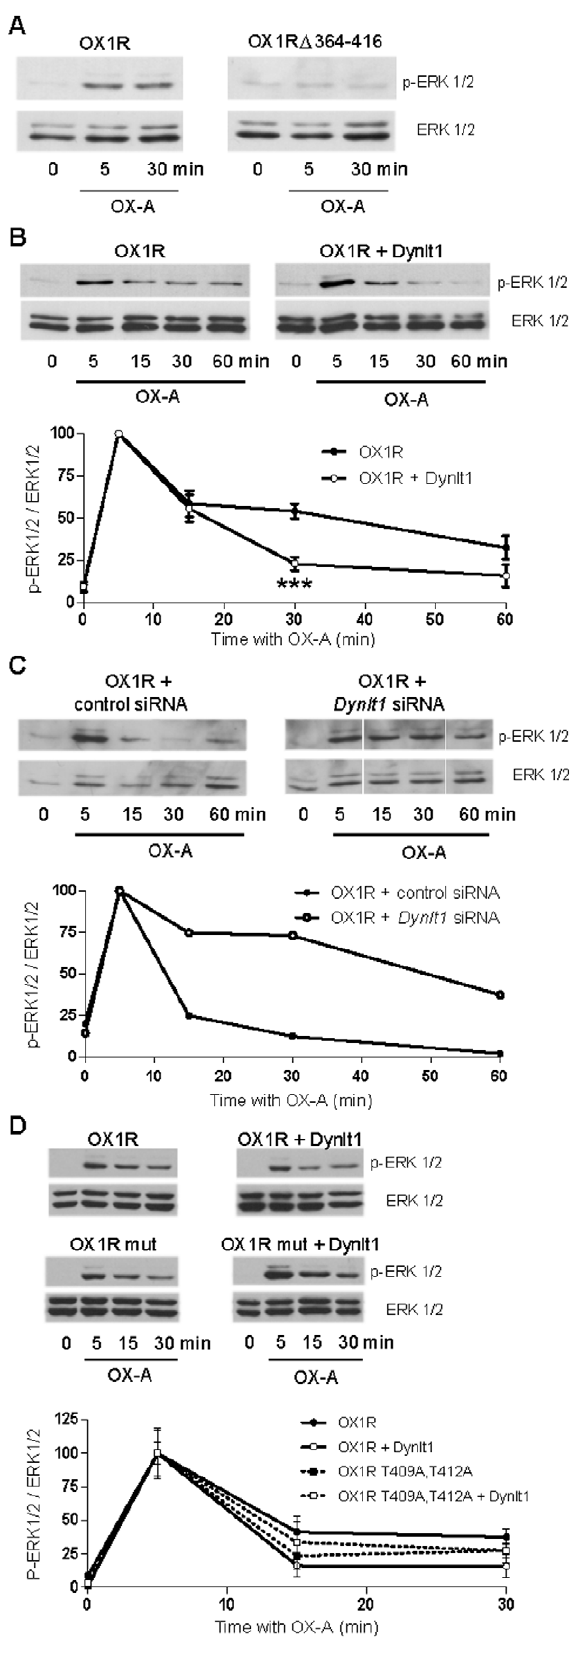
Figure 6. Modulation of OX1R-mediated signaling by Dynlt1. ( A ) HEK293 cells were transfected with a V5-OX1R or V5-OX1R D 364– 416 expression vector and stimulated with 500 nM OX-A for the indicated times. Protein extracts were analyzed by SDS-PAGE and Western blotting with anti-phospho-ERK1/2 and anti-ERK1/2 antibodies. ERK1/2 are quickly phosphorylated after OX-A stimulation and OX1R CTD is essential to this response. V5-OX1R D 364–416, V5-OX1R lacking its CTD. ( B–D ) Transfected HEK293 cells were stimulated with 100 nM OX-A for the indicated times and processed as in (A). ( B ) Co-expression of Dynlt1 leads to a less sustained ERK1/2 activation in response to OX- A. Blots are from a representative experiment. The graph shows a combination of 4 independent experiments. ***: p , 0.001 vs data without Dynlt1 transfected (ANOVA followed by post-hoc analysis at the different times). ( C ) Down-regulation of Dynlt1 by a siRNA (10 nM, expression reduced by 88%) leads to a sustained activation of the ERK1/ 2 pathway in response to OX-A. This experiment was repeated twice, each in duplicates, with similar results. The blots and the graph present the results from one of these experiments. ( D ) Dynlt1 does not lead to a less sustained ERK1/2 activation in response to OX-A when co- expressed with OX1R mutant T409A, T412A. This experiment was repeated twice, each in triplicates, with similar results. The blots and the graph are from one of these experiments.